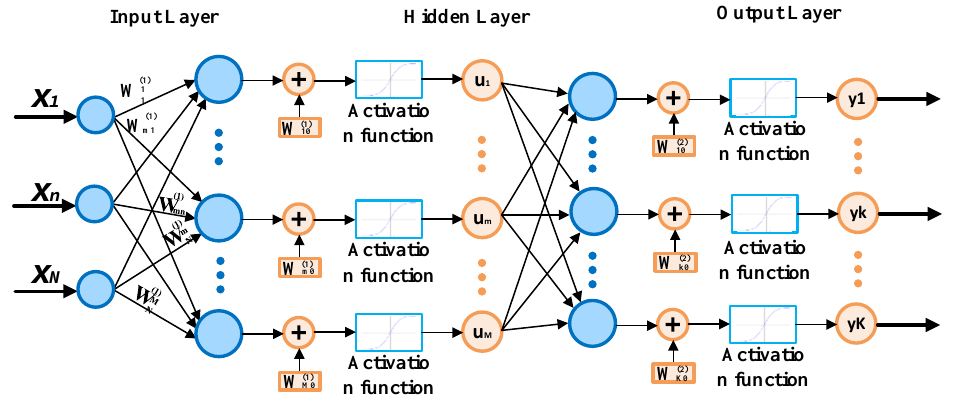
Figure 15. MLP exemplary structure.